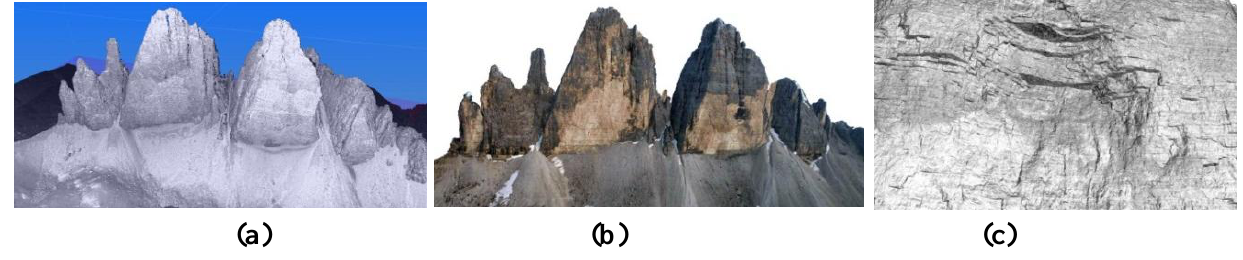
Figure 1. 3D surveying and modeling of the Three Peaks in the Dolomites area, Italy ( ca. 2 × 0.8 km), based on oblique airborne laser scanning [47]. The acquired point cloud (a) is rendered in a photo-realistic mode (b) using terrestrial images projected onto the acquired 3D data. (c) A closer view of the 3D geometric model with an average resolution of 5 cm.